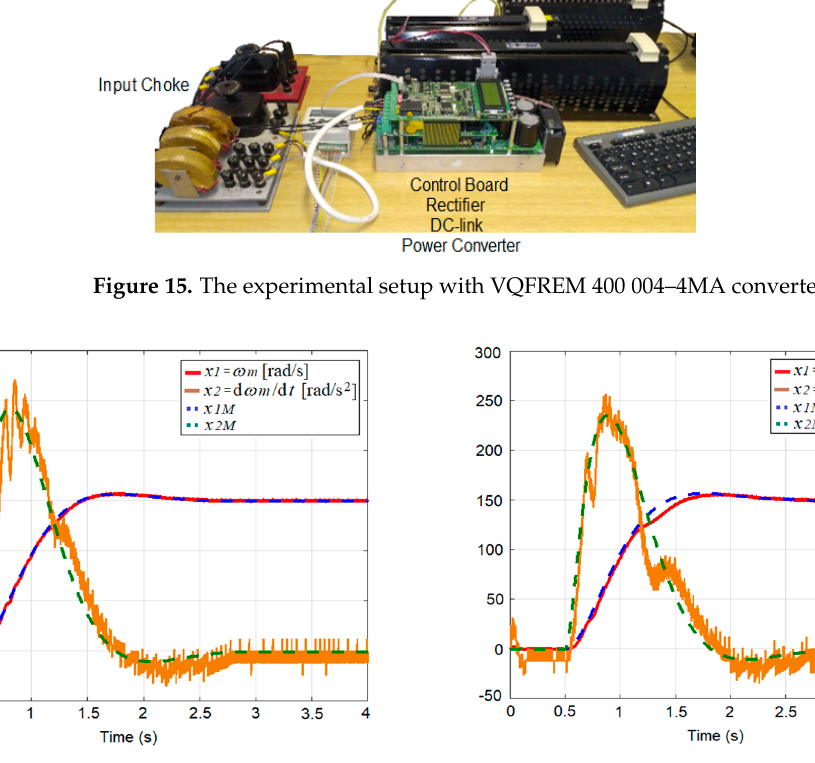
Figure 15. The experimental setup with VQFREM 400 004–4MA converter.